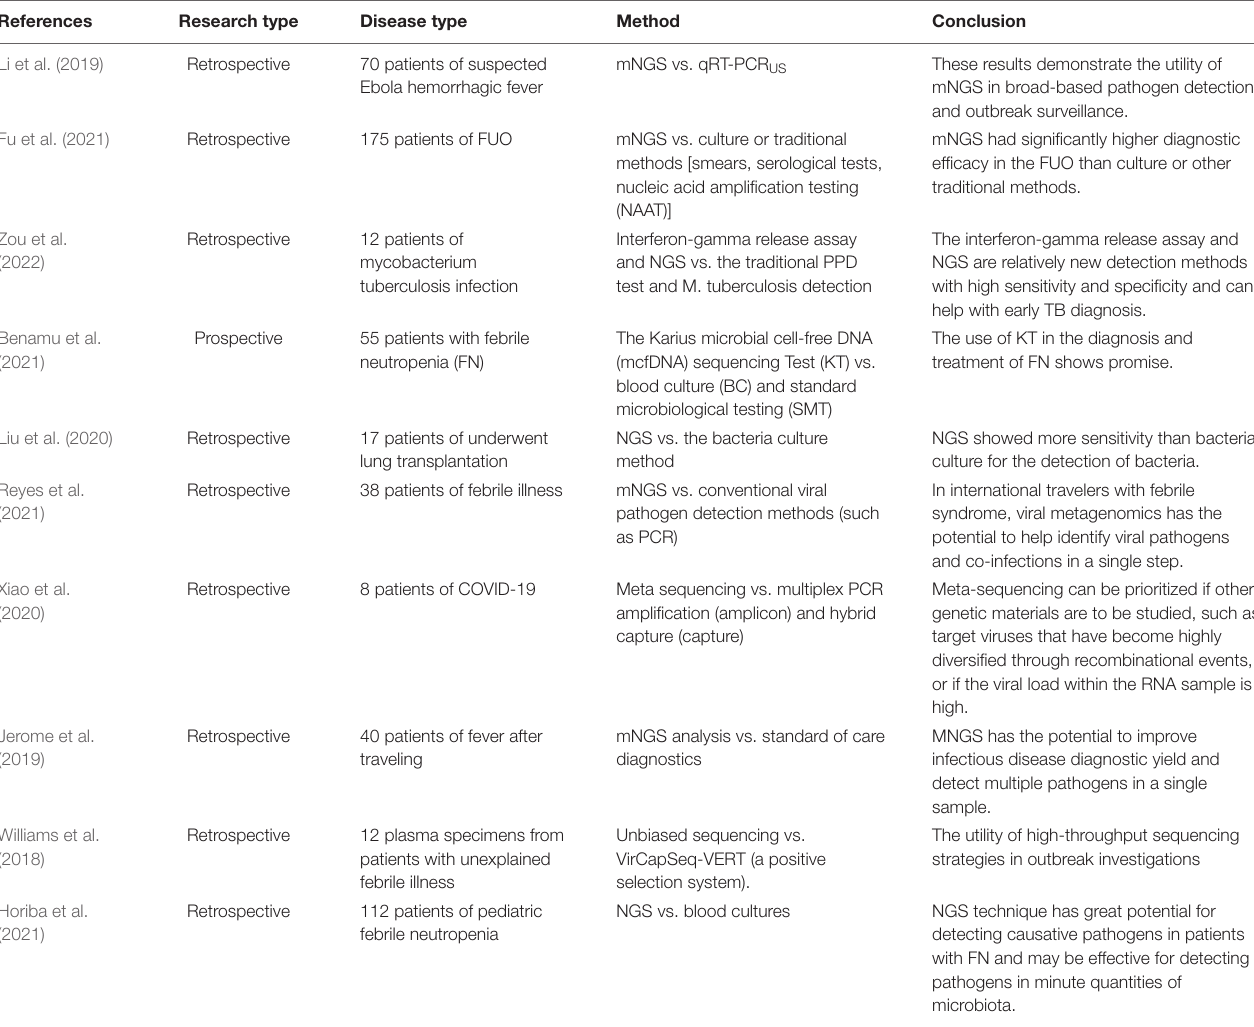
TABLE 1 | List of sequencing associated with fever or infectious disease’